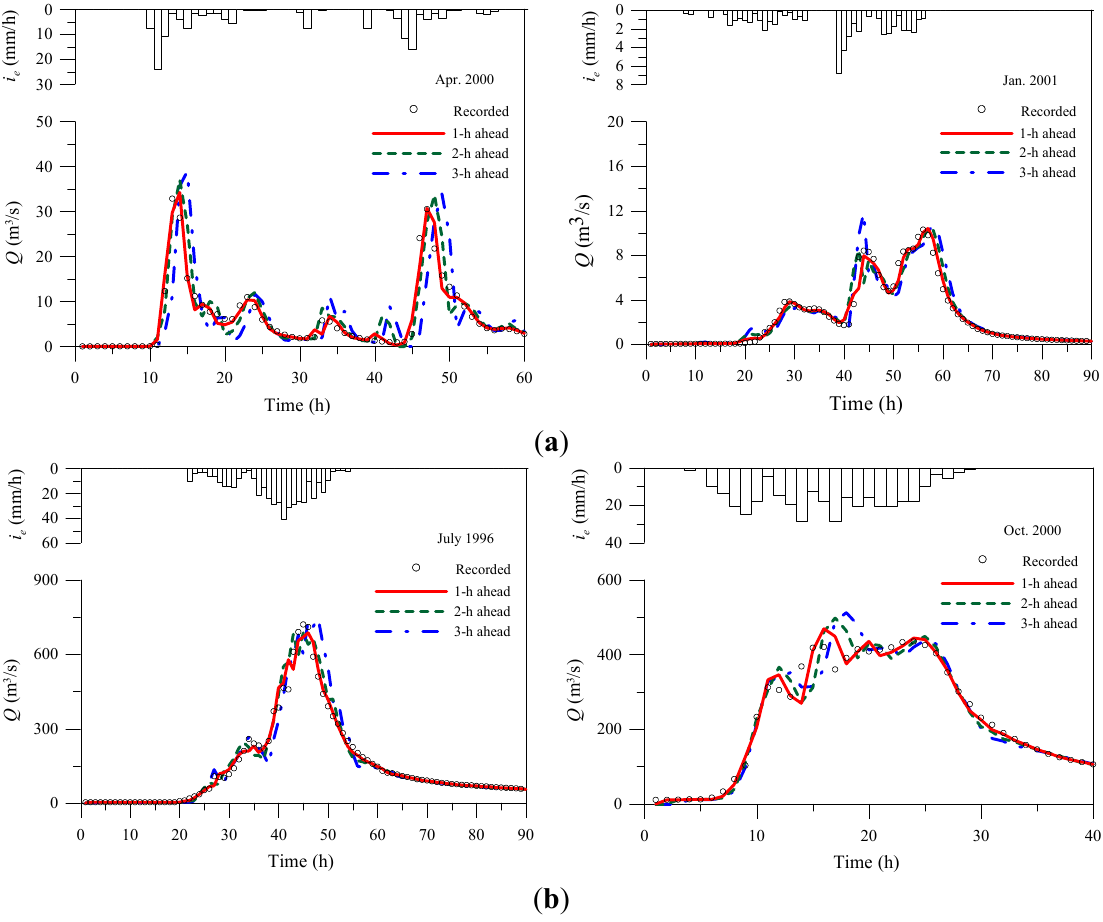
Figure 11. Flow forecasting using forecast rainfall and flow updating algorithm in Goodwin Creek and San-Hsia watersheds: ( a ) Goodwin Creek watershed (STA 01); ( b ) San-Hsia